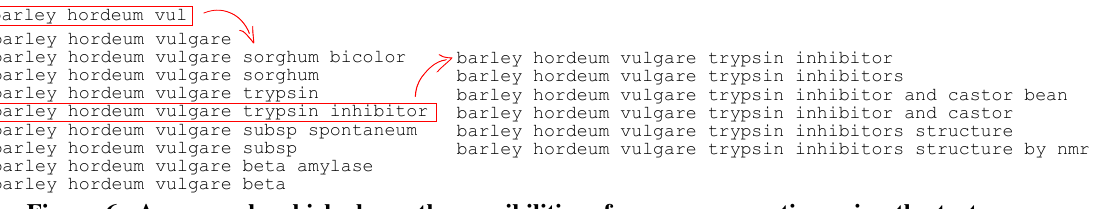
Figure 6: An example which shows the possibilities of a query suggestion using the text corpus as textual background. The first phrase is barley hordeum vul and the second is barley hordeum vulgare trypsin inhibitor .